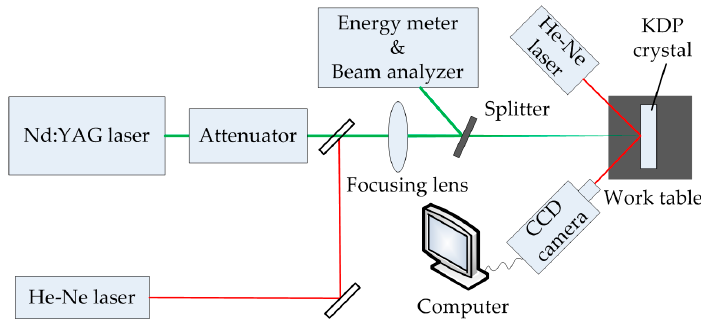
Figure 2. Schematic of experimental setup for measuring laser induced damage of Potassium Dihydrogen Phosphate (KDP) crystals.